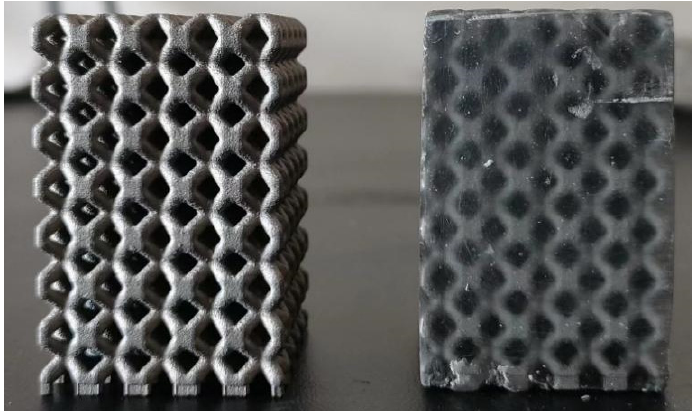
Figure 4. Fabrication of 316L metallic lattice structure and epoxy/316L metallic lattice structure. Materials 2023 , 16 , x FOR PEER REVIEW